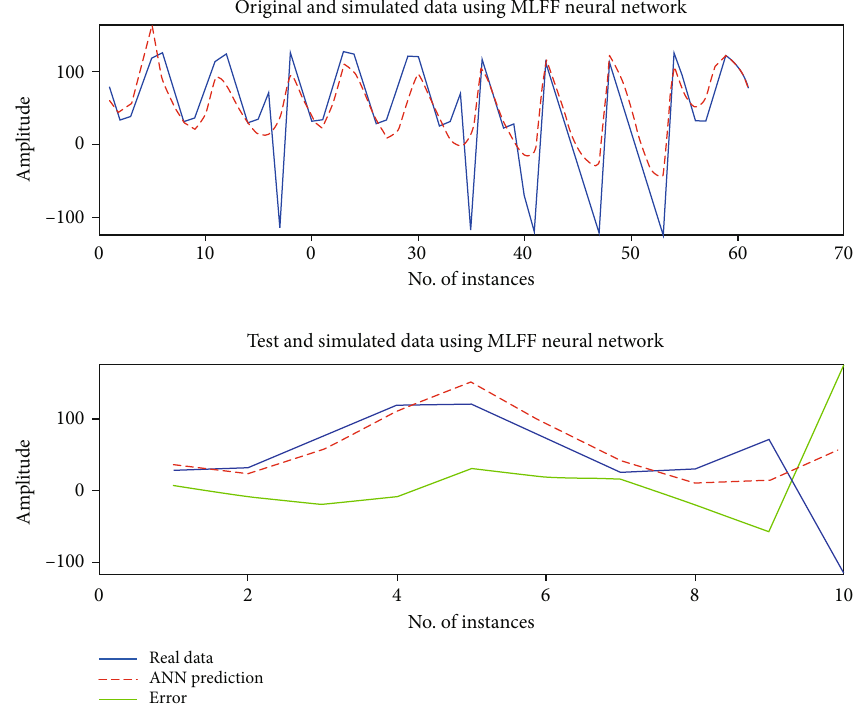
Figure 12: Simulation results of the neural network for train and test data.